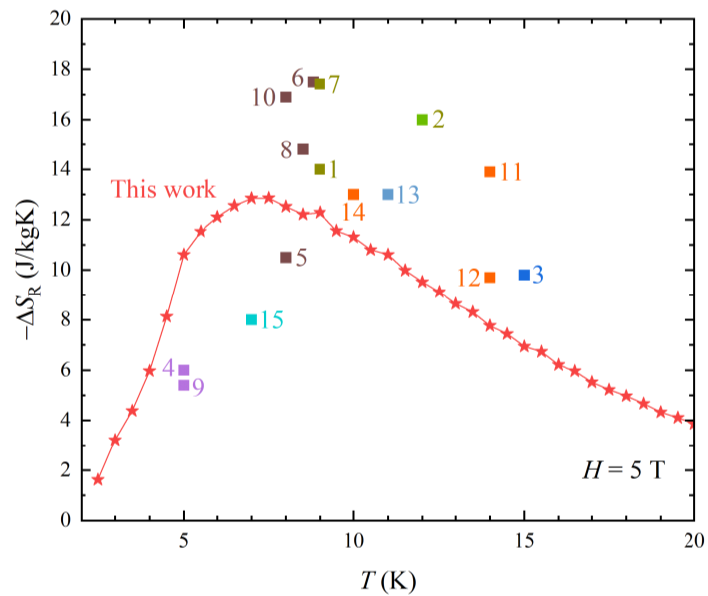
Figure 7. Temperature dependent R-MCE − ∆ S R of NdAlGe and other single materials, ever reported. Table 2. R-MCE of single materials in Figure 7.